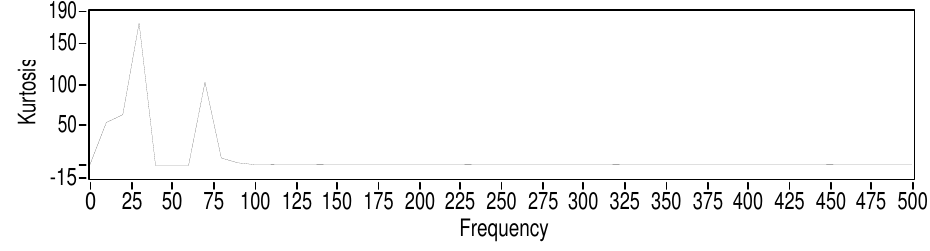
Figure 3. SK analysis over a sag. SK analysis shown from 0 to 500 Hz of a sag with Gaussian additive noise with σ = 0 . 05